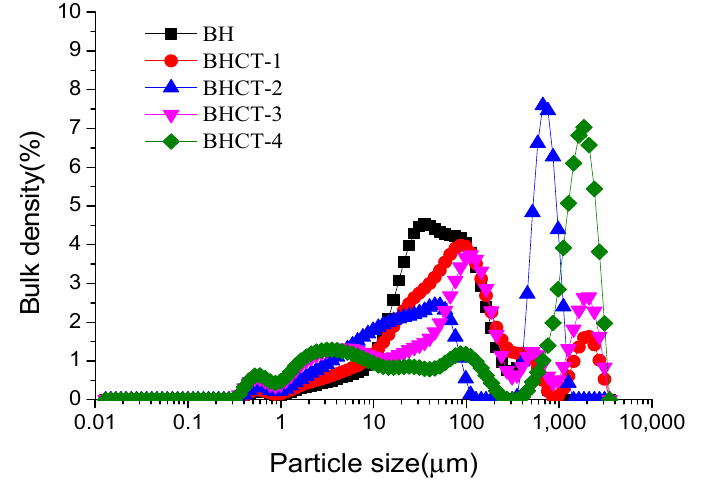
Figure 2. Particle-size distribution of composite gel under different crosslinker concentrations.